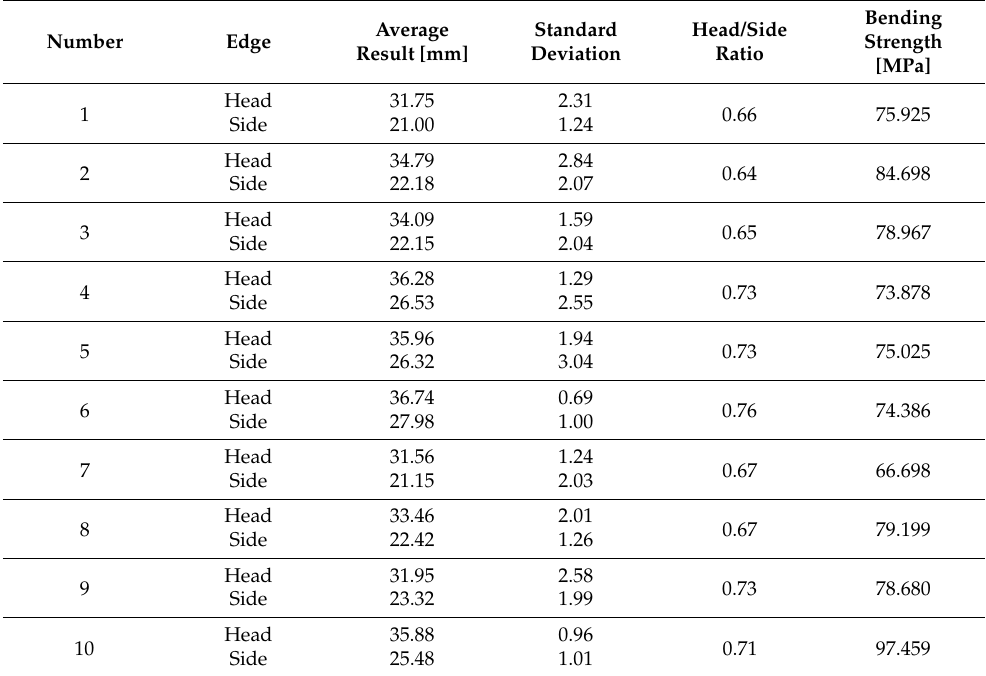
Table 2. Results of Schmidt hammer tests for spruce wood elements and bending strength obtained in the destructive test in accordance with [38].